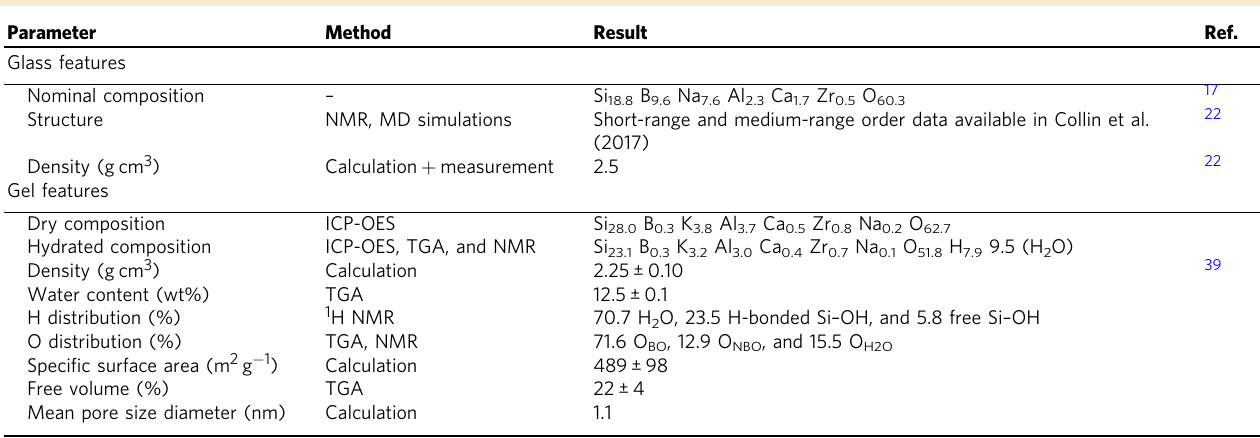
Details about the determination of H and O atoms distribution, speci fi c surface area, free volume, and mean pore size are given in Supplementary Note 1. Pore size is too small to be experimentally determined. The value of ∼ 1nm is in good agreement with diffusion experiments with dyes